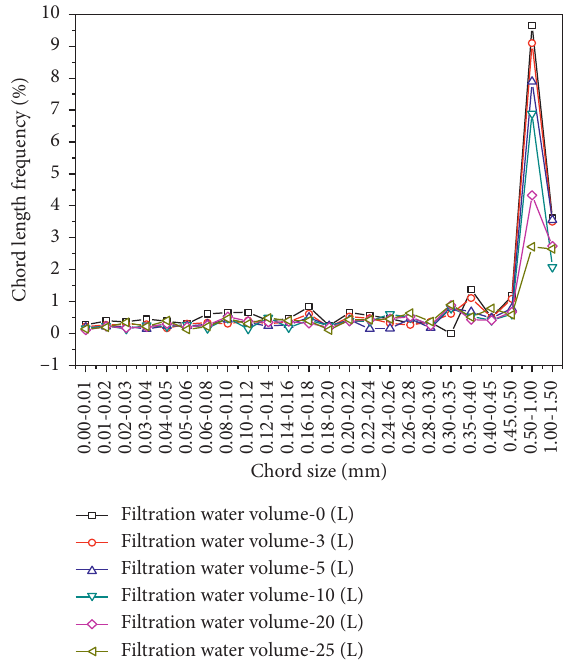
Figure 7: Chord size distribution with the different filtration volumes.